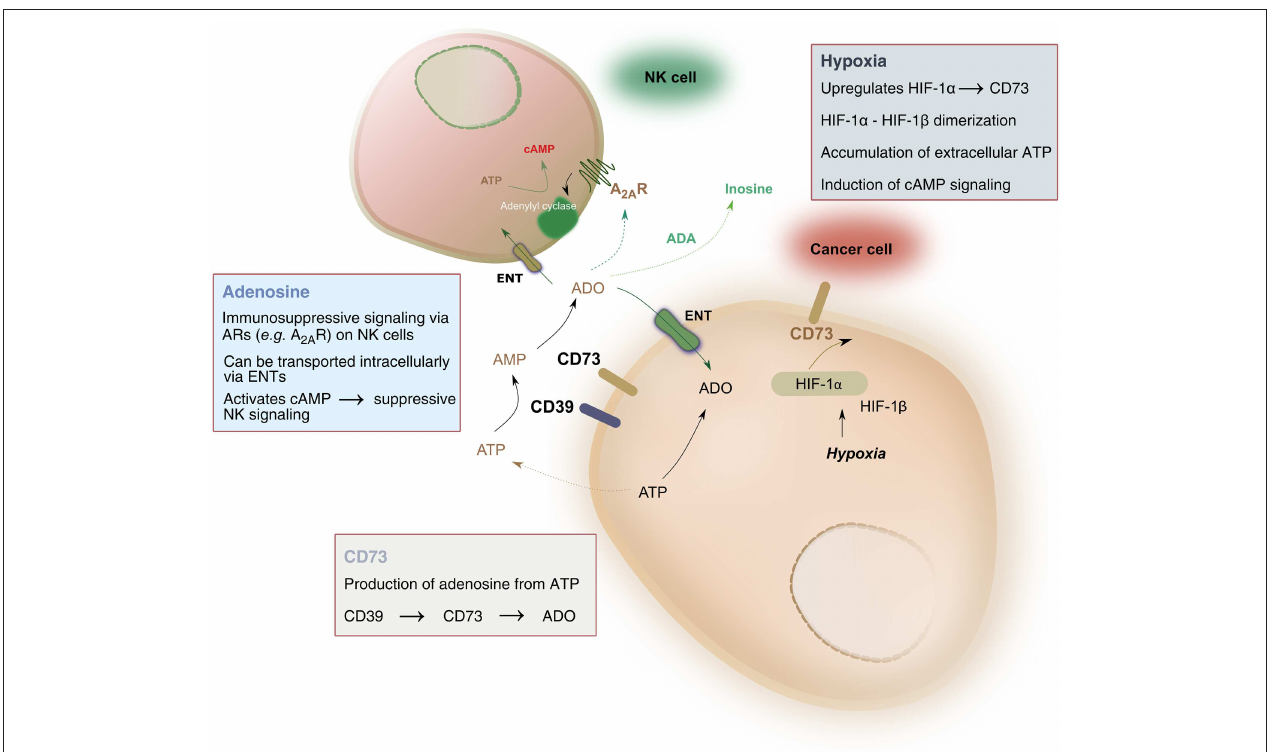
FIGURE 1 | Hypoxia-CD73 signaling on NK cells. Hypoxia induces the expression of CD73 via HIF-1, itself consisting of HIF1- α and HIF-1 β . HIF-1, in turn, regulates immune responses to hypoxia by controlling glycolytic metabolism and NK cells’ adaptation to low oxygen. CD73 dephosphorylates AMP, produced by the conversion of ATP to AMP catalyzed by CD39, to generate adenosine. Extracellular adenosine can be transported intracellularly via equilibrative nucleoside transporters (ENT) or it can signal via adenosine receptors on the surface on NK cells, most notably the A 2A receptor (A 2A R). A 2A R signaling via adenosine was shown to result in dysfunction of NK cell metabolic and effector functions. Extracellular adenosine can also be converted to inosine via the catalytic activity of adenosine deaminase (ADA).